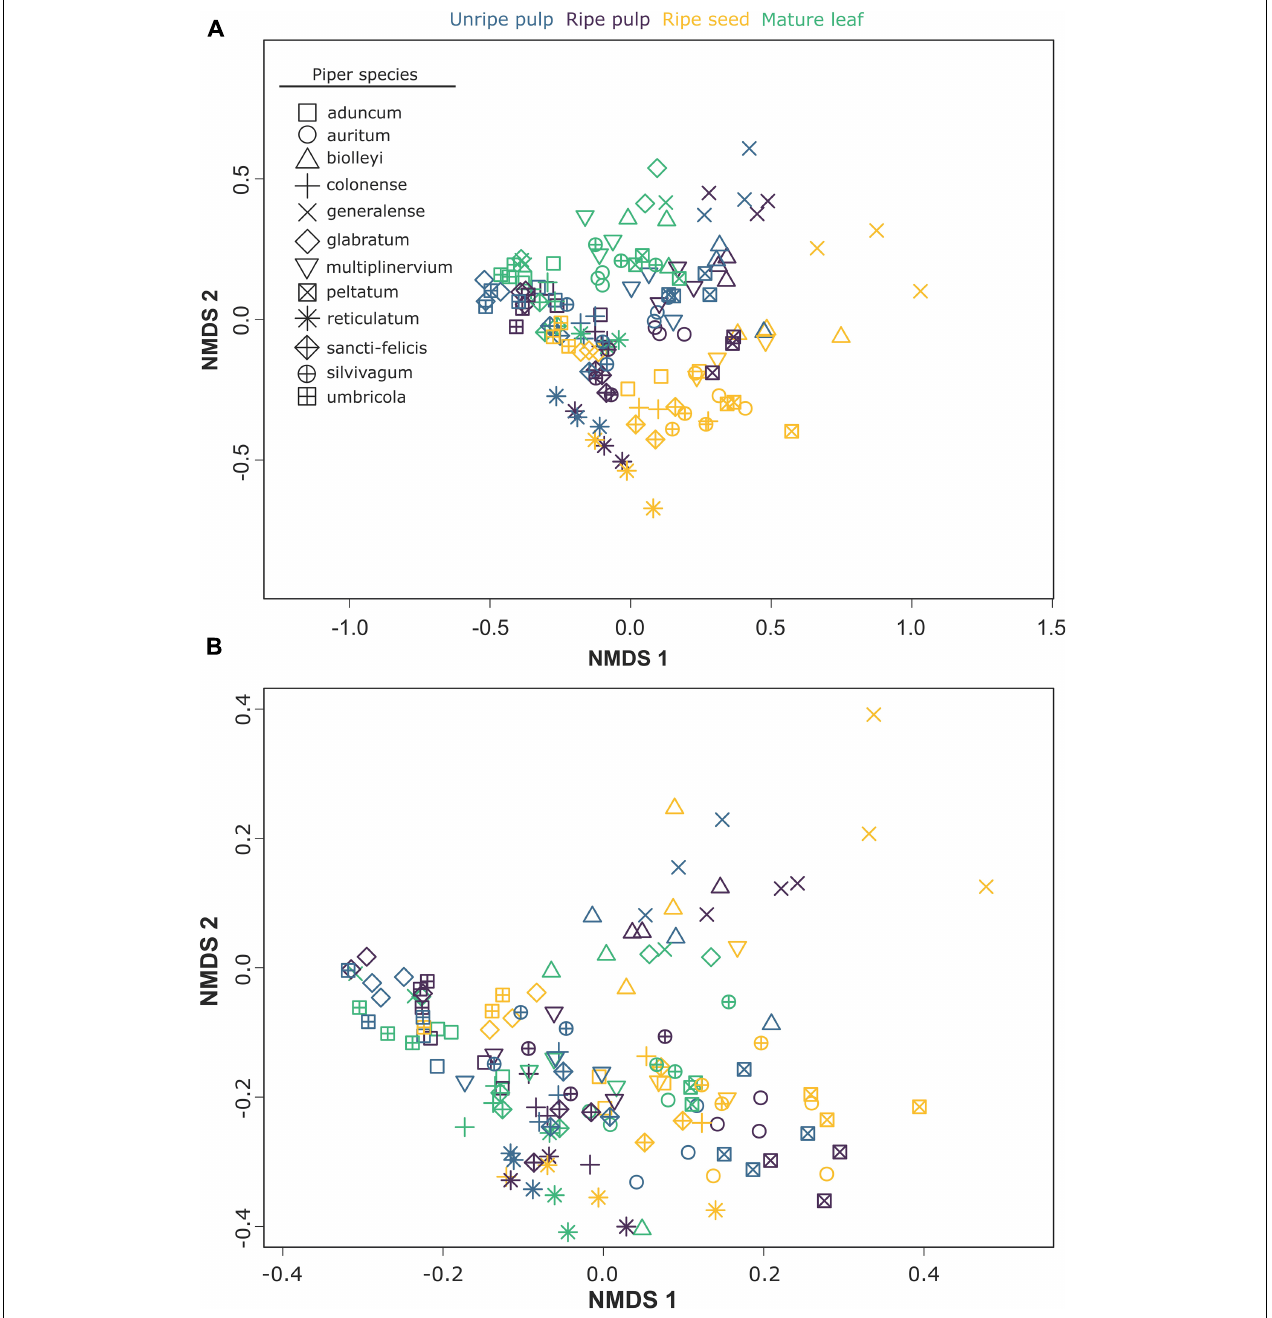
FIGURE 3 | NMDS plots showing the effects of organ and species on two aspects of multivariate chemical composition across samples: (A) compound occurrences (presence/absence) and (B) structural composition. organ × species: F ( 33 , 95 ) = 1.99, P = 0.001; Figure 3A ]. Pairwise comparisons among organs indicated strong differences among all organs ( P = 0.001 for all comparisons).